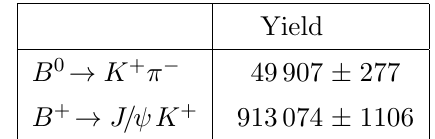
Table 1 . Yields of normalisation channels obtained from (cid:12)ts to data.